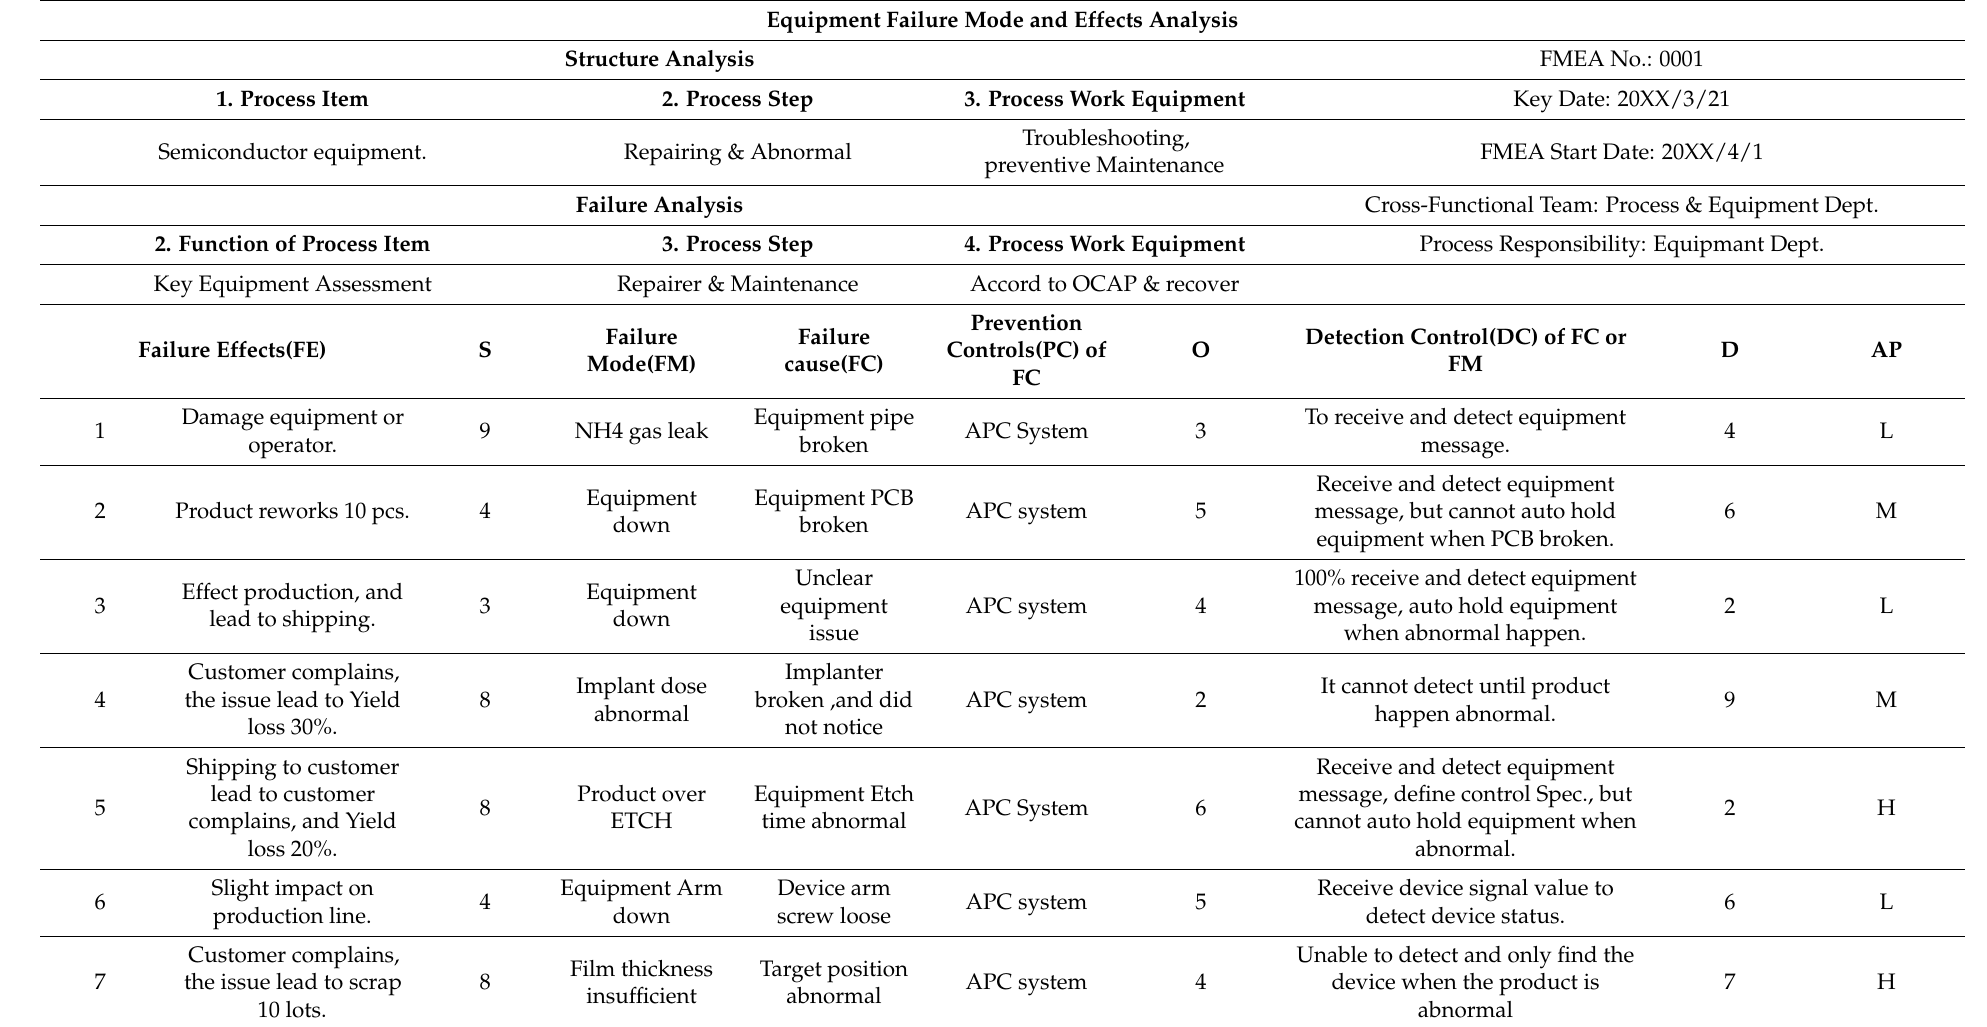
Table 2. Failure mode and effects analysis of equipment in a semiconductor